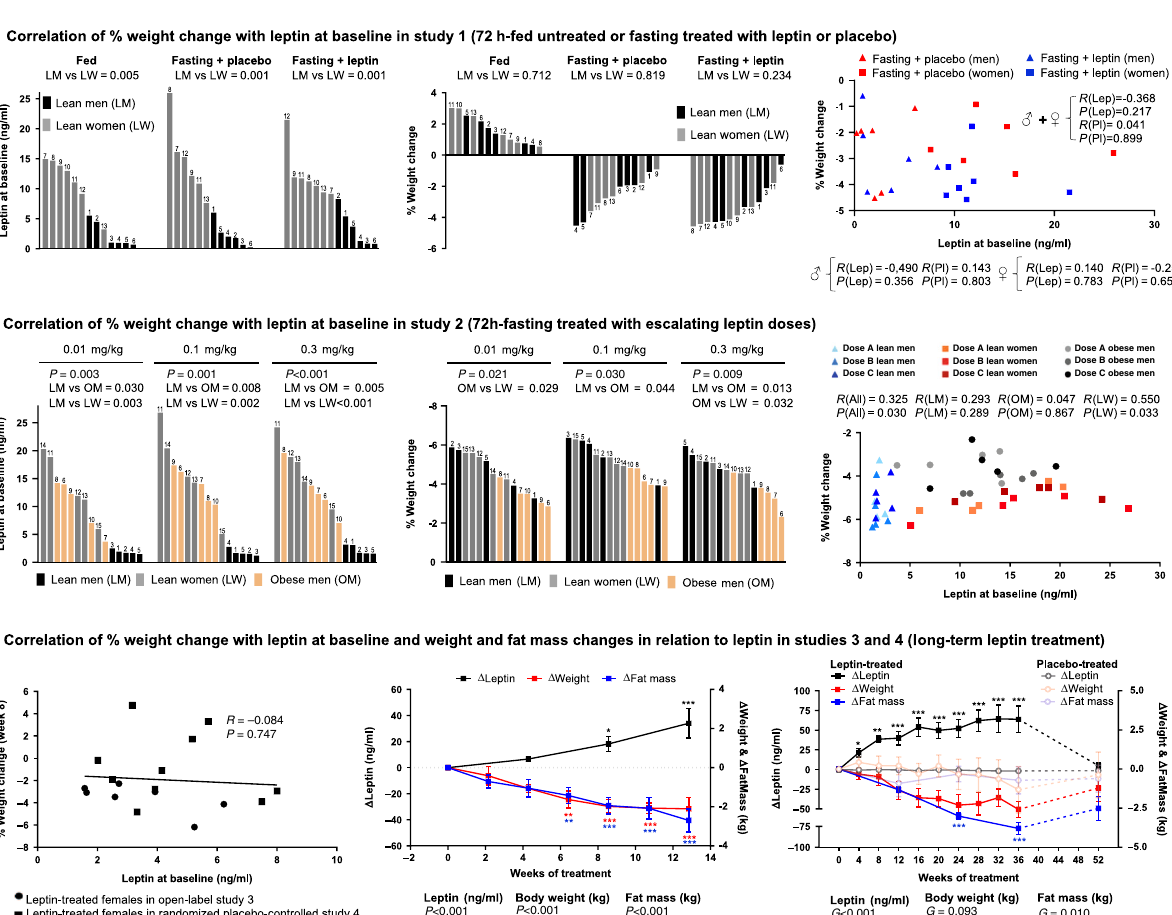
Results Baseline leptin levels do not predict weight-loss magnitude . In study 1 (three interventions: fed — untreated, fasting — treated with leptin, and fasting — treated with placebo) and study 2 (six interventions: fed and fasting state treated with physiological, supraphysiological, or pharmacological doses of leptin) (see Fig. 1